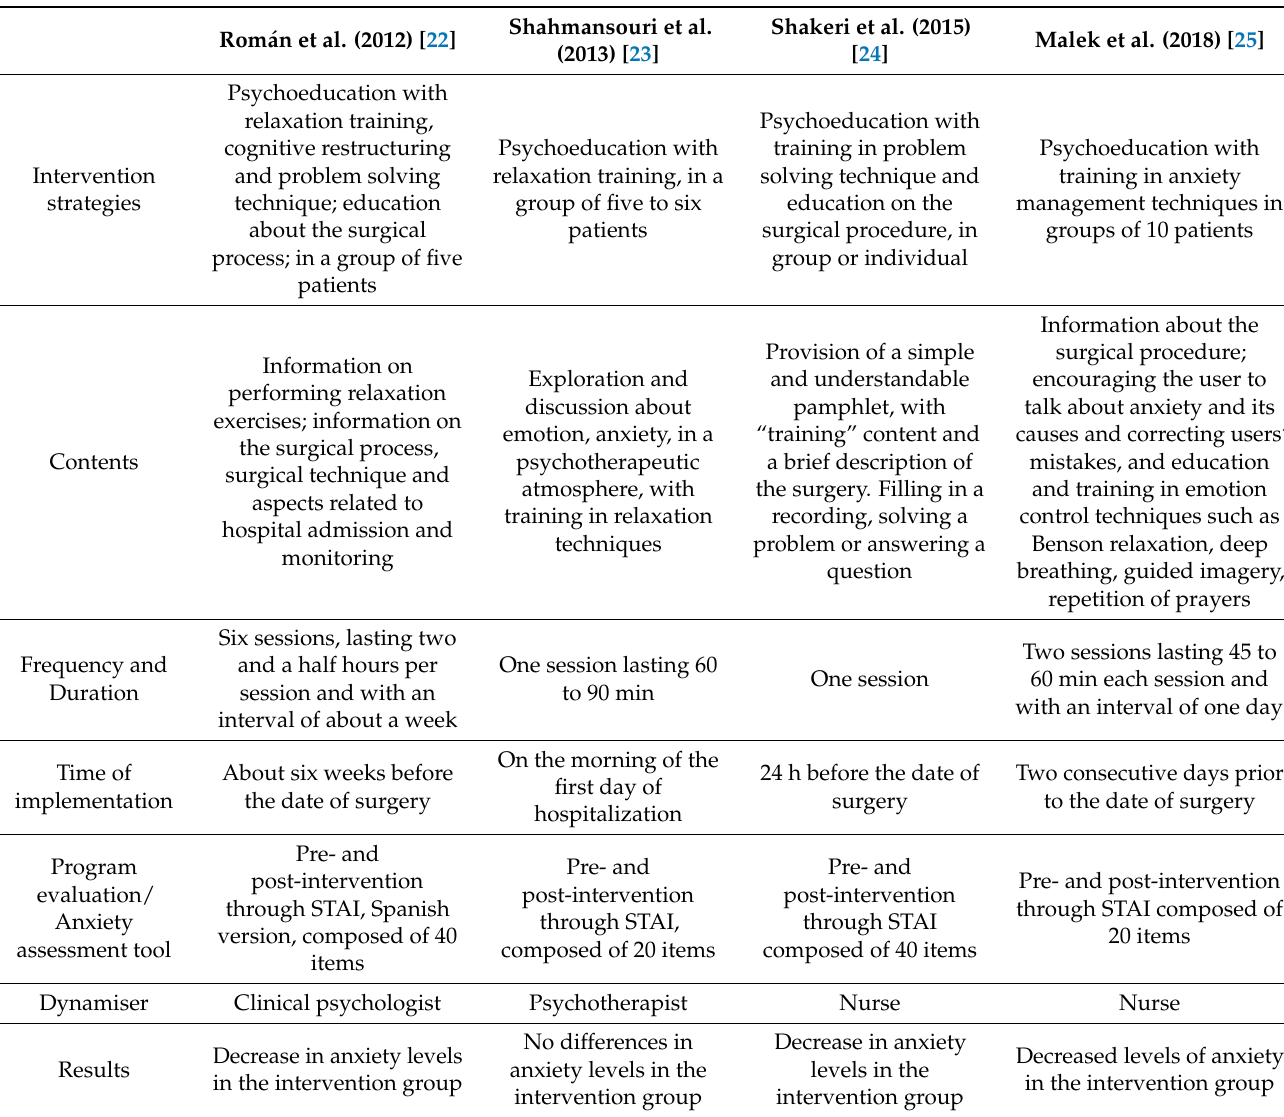
Table 2. Characteristics of intervention